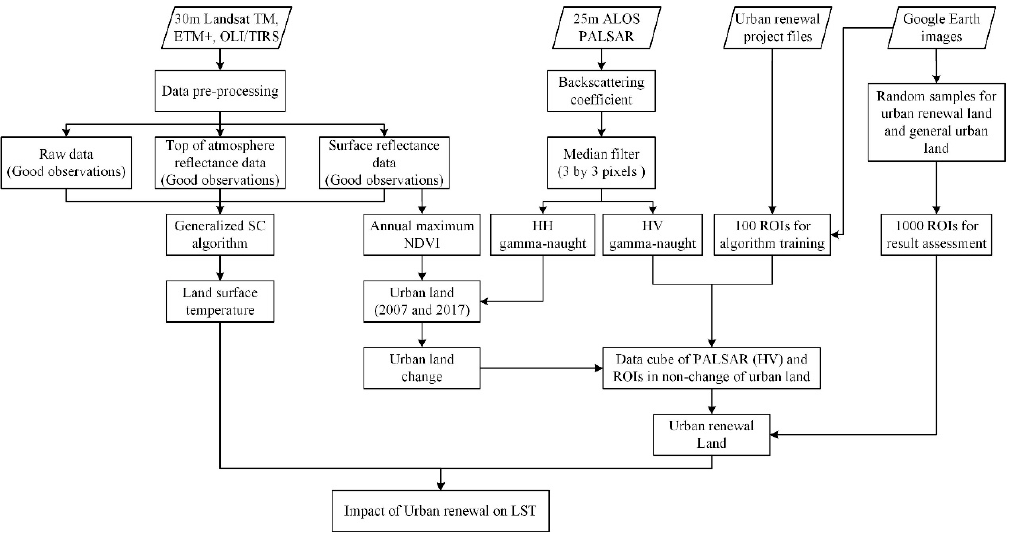
Figure 3. Workflow for analyzing the impact of urban renewal on land surface temperature (LST), based on the combination of Landsat Thematic Mapper (TM)/Enhanced Thematic Mapper Plus (ETM+)/Operational Land Imager (OLI)/ Thermal Infrared Sensor (TIRS) and Advanced Land Observation Satellite (ALOS) Phased Array type L-band Synthetic Aperture Radar (PALSAR) images.